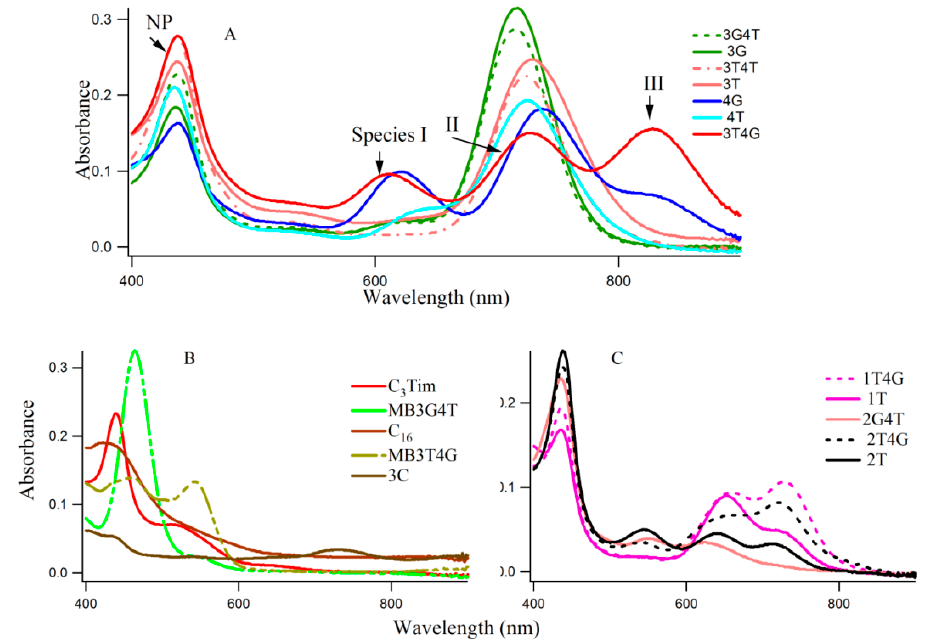
Figure 1. ( A – C ) show typical absorption spectra of silver nanolcusters on various DNA templates (15 μ M DNA with 90 μ M AgNO 3 and 90 μ M NaBH 4 ). The sequences of the DNA templates are given in Scheme 1.